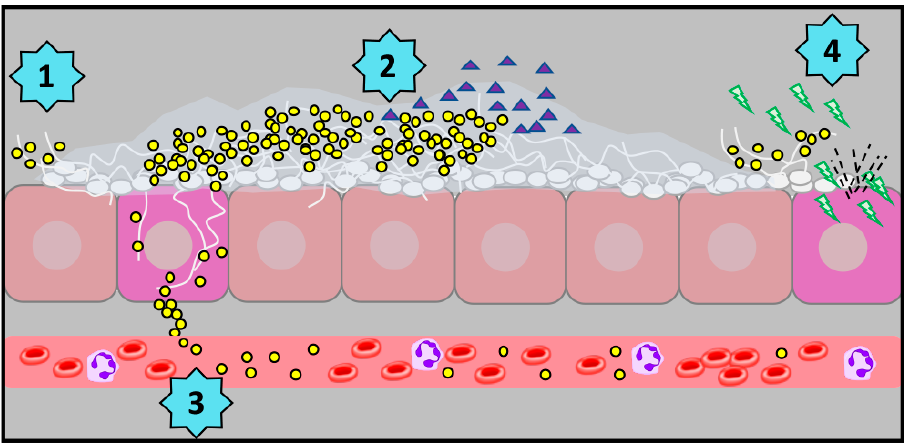
Figure 3. Schematic of C. albicans – S. aureus interactions. (1) S. aureus preferentially attaches to the hyphal filaments of C. albicans via binding of the candidal adhesin Als3p. (2) Encasement of S. aureus in fungal biofilm matrix components (including β -1,3-glucan) impairs penetration of antibiotics (purple triangle) by sequestration of drug. The C. albicans QS molecule farnesol also upregulates drug e ffl ux pumps in S. aureus to enhance tolerance to antibacterials. (3) S. aureus is able to gains access into subepithelial spaces by “hitchhiking” onto the invasive C. albicans hyphae. S. aureus may also then disseminate to distant sites (including the kidneys) following co-invasion via the bloodstream. (4) C. albicans enhances the staphylococcal agr QS system, ultimately leading to elevated levels of α -toxin (green bolts), cell damage, and synergistic lethality during polymicrobial